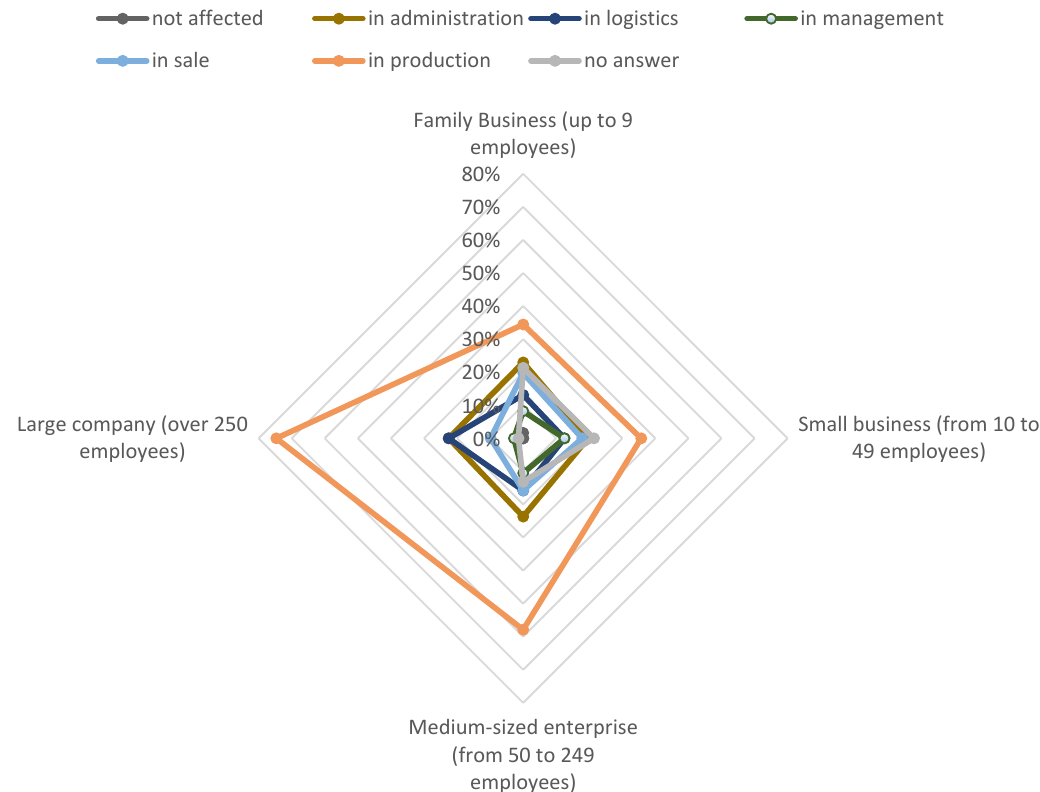
Figure 4. Areas where Industry 4.0 concept would affect the number of employees.